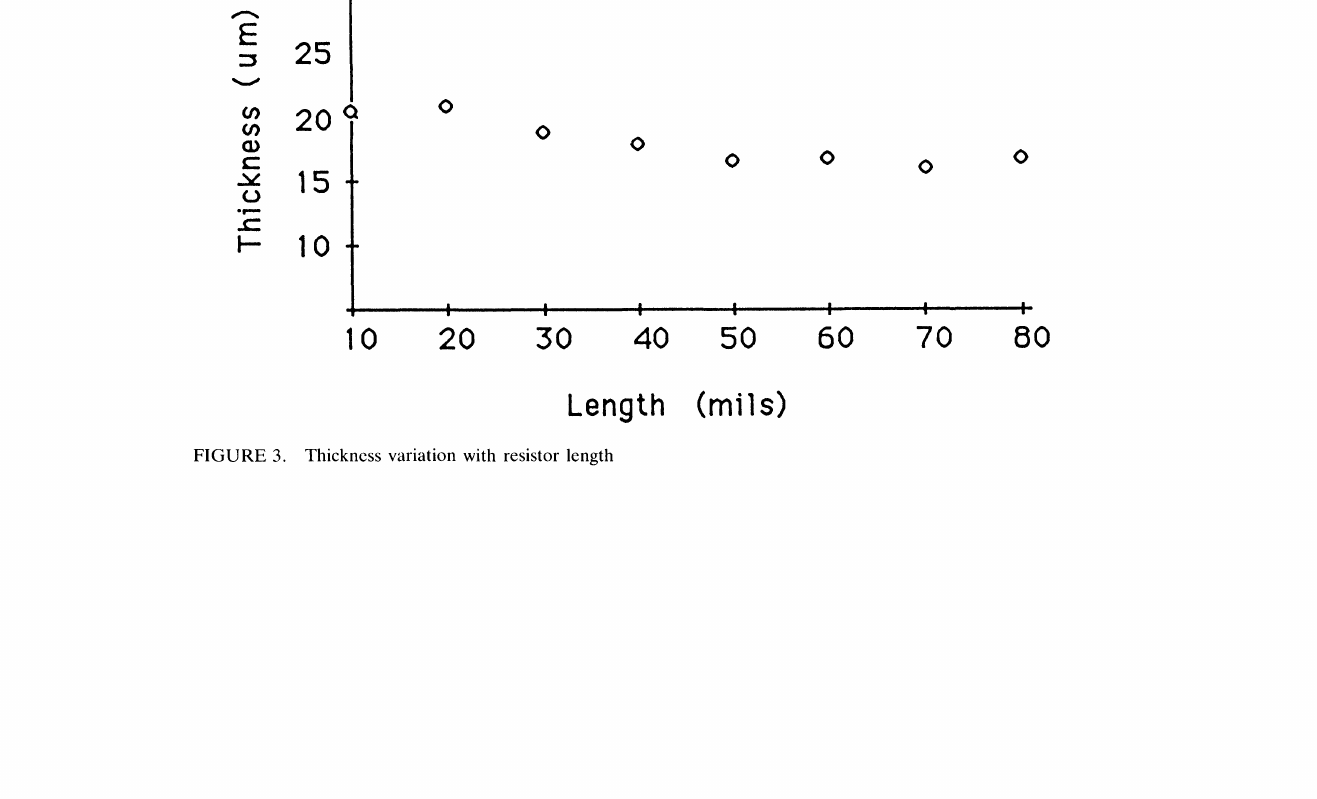
FIGURE 2. Dcpcndcnce of shcet resistance on resistor length less than 50 mils are thicker. The thickness is constant down to 50 mils and increases with further decrease in length. This behavior of sheet resistance and thickness is independent of the resistance value of the paste.